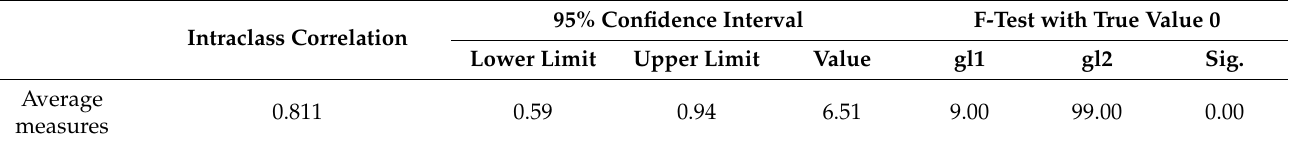
Table 5. Intraclass correlation